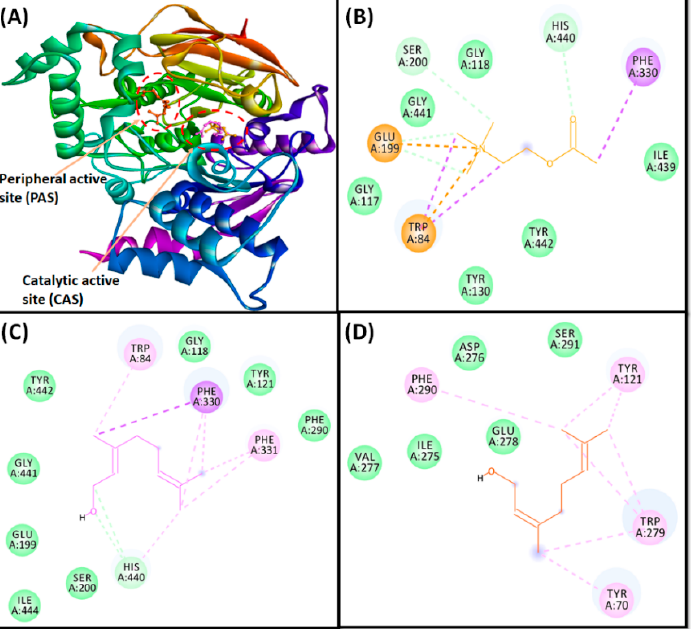
Figure 5. Interaction of target protein, AChE with geraniol and their respective control ligand. ( A ) Superimposed image of geraniol and acetylcholine in CAS and PAS locations of AChE; ( B ) interactions between CAS residues of AChE and acetylcholine; ( C ) interactions between CAS residues of AChE and geraniol; ( D ) interactions between PAS residues of AChE and geraniol.